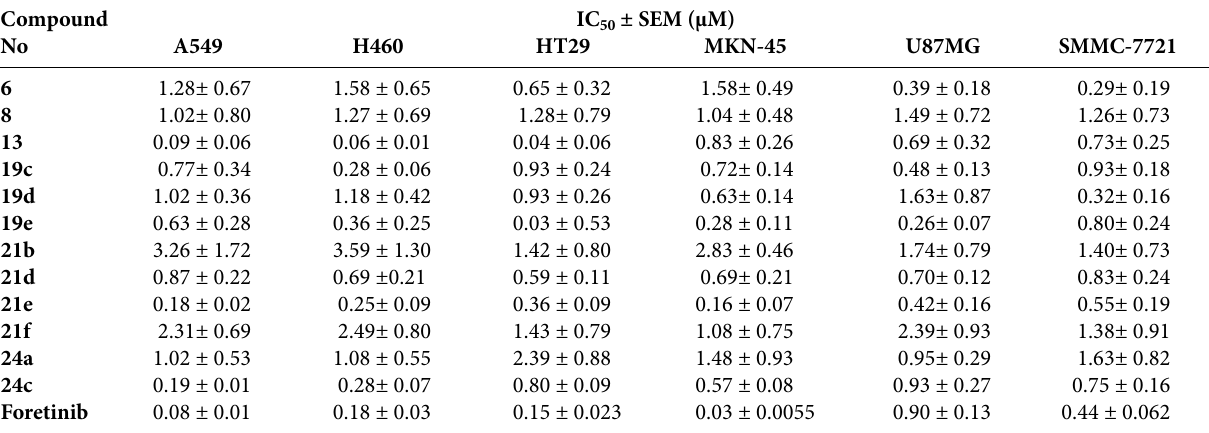
Table 2. In vitro growth inhibitory effects IC 50 ± SEM (µM) of the most potent compounds